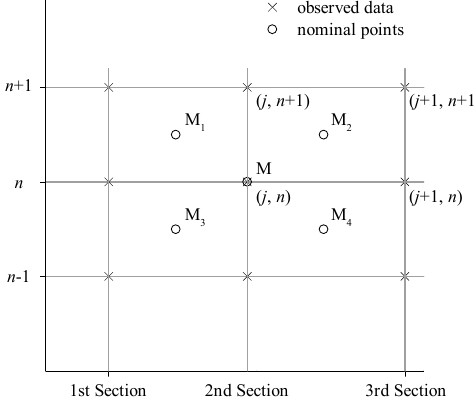
Figure 3. Representation of relevant points in the discretization method.